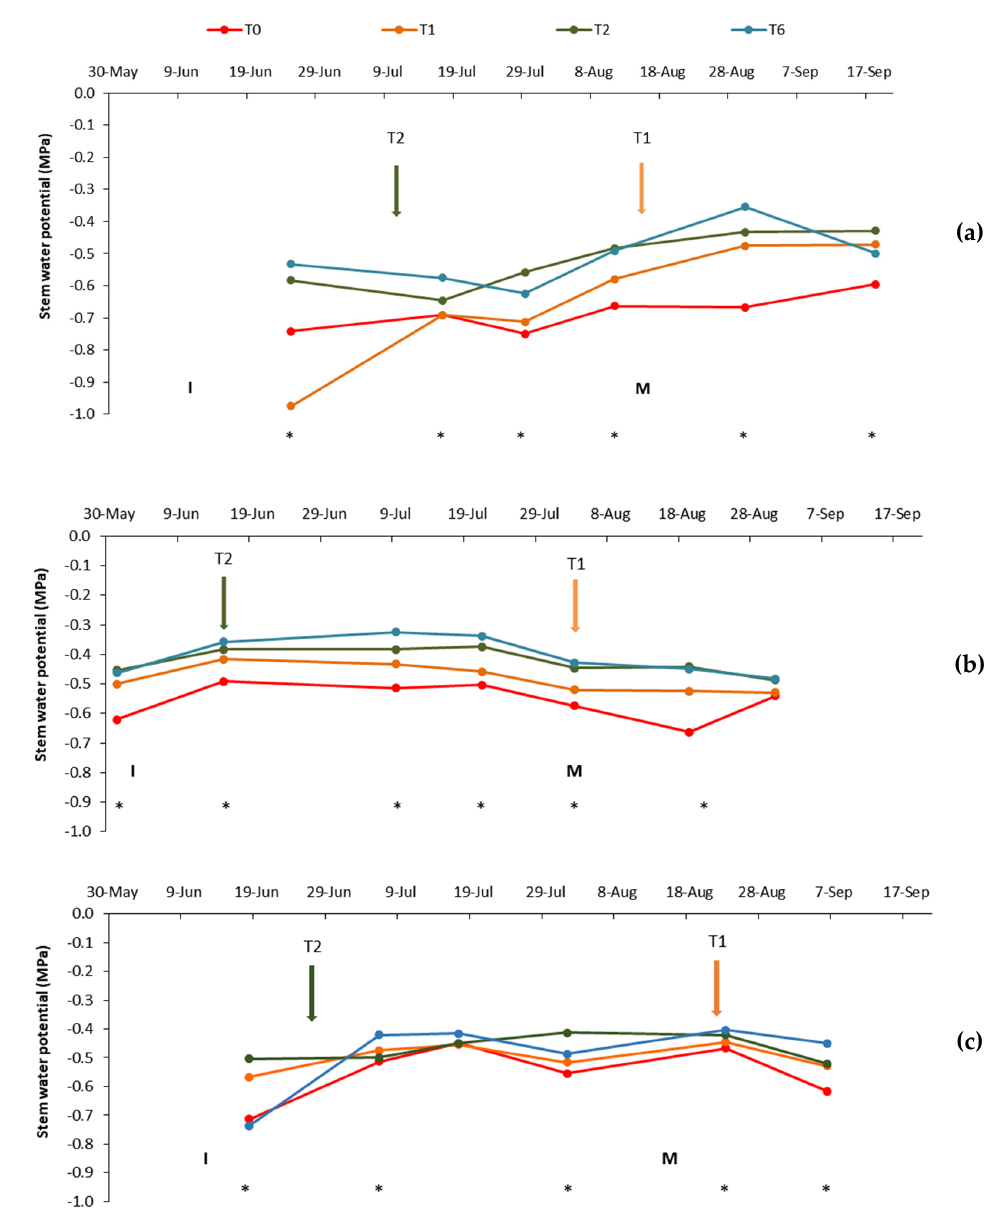
Figure 2. Evolution of stem water potential during the three growing seasons: ( a ) 2016; ( b ) 2017; and ( c ) 2018. Arrows represent the irrigation start date. I, flowering; M, veraison; * indicates significance at p < 0.05. T0, Rainfed (0% ET o ); T1, drip irrigated at 30% ET o from the beginning of veraison to harvest; T2, drip irrigated at 30% ET o from pea size to harvest; and T6 (control), drip irrigated at 30% ET o from budburst to harvest.